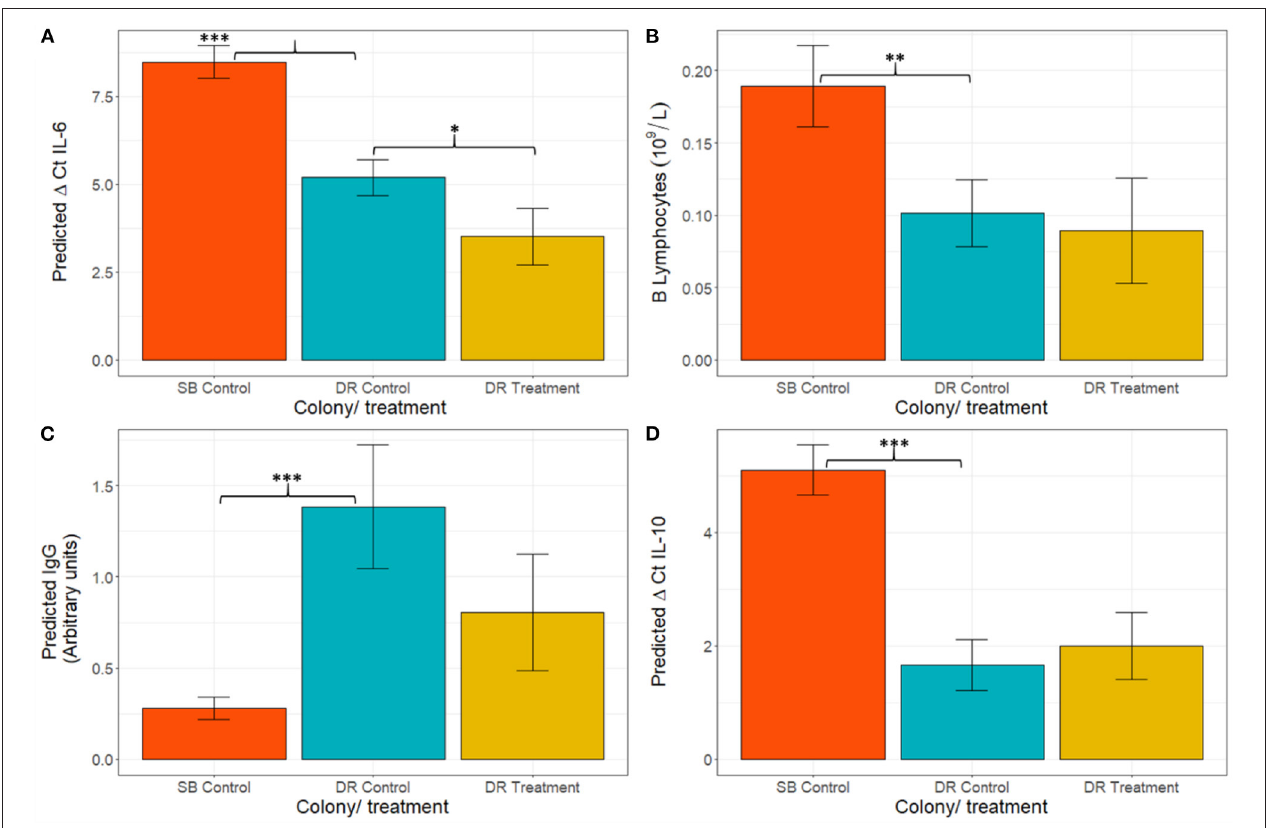
FIGURE 4 | Figure Model estimated mean ± standard error for (A) 1 Ct IL-6, (B) B lymphocytes, (C) IgG, and (D) 1 Ct IL-10. Statistical models for IgG and B lymphocytes were fitted on a log scale, but model derived back-transformed means (emmeans package, R) are presented in figures. Significance codes ( p ): “*” 0.05; “**” 0.01; “***” 0.001. Lower 1 Ct indicates greater cytokine